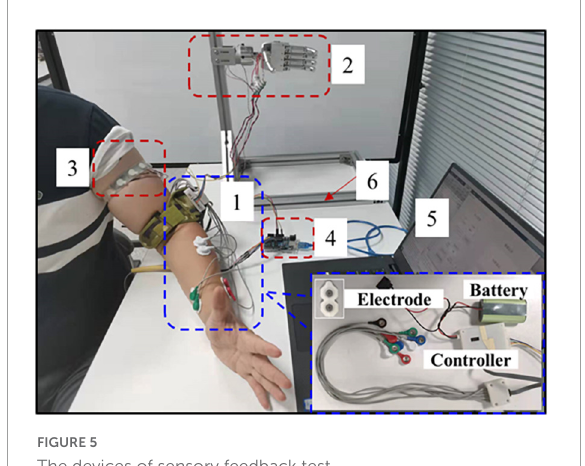
FIGURE5 The devices of sensory feedback